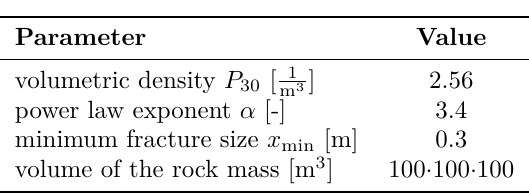
Table 1. Parameters of